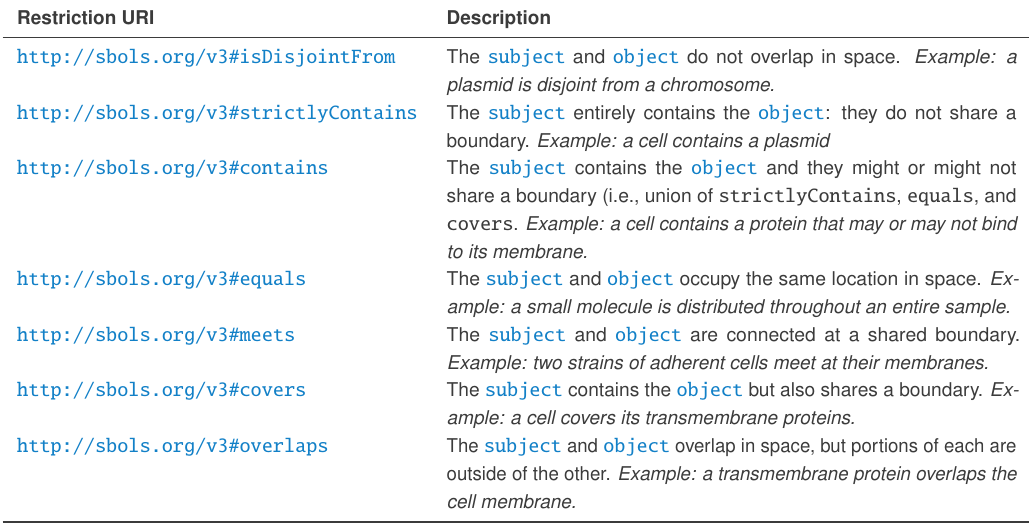
Table 8: RECOMMENDED URI s for expressing topological relations with the restriction